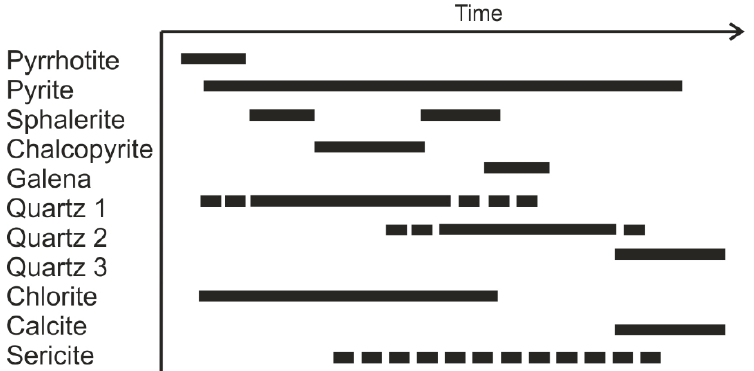
Figure 3. Typical precipitation series of the commonly observed paragenesis at the various study sites.